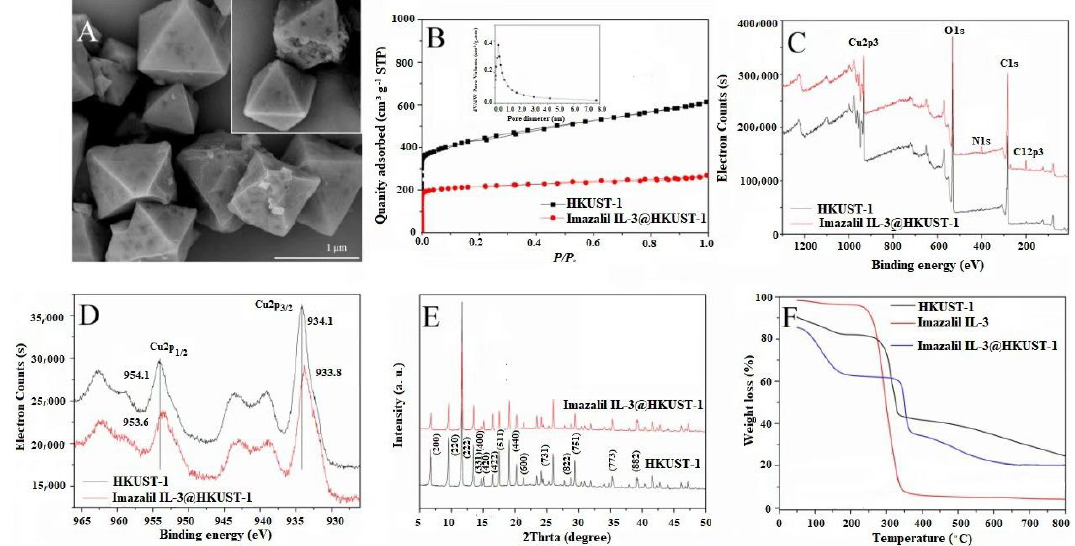
Figure 1. Characterization of HKUST-1 and imazalil IL-3@HKUST-1. ( A ) SEM images of HKUST-1; ( B ) N 2 adsorption–desorption isotherms and pore-size distribution of HKUST-1 (inset); ( C ) X-ray photoelectron spectra; ( D ) X-ray photoelectron Cu2p3 spectra; ( E ) X-ray diffraction patterns of HKUST-1 and imazalil IL-3@HKUST-1; and ( F ) thermogravimetric analysis profiles of HKUST-1, imazalil IL-3 and imazalil IL-3@HKUST-1.